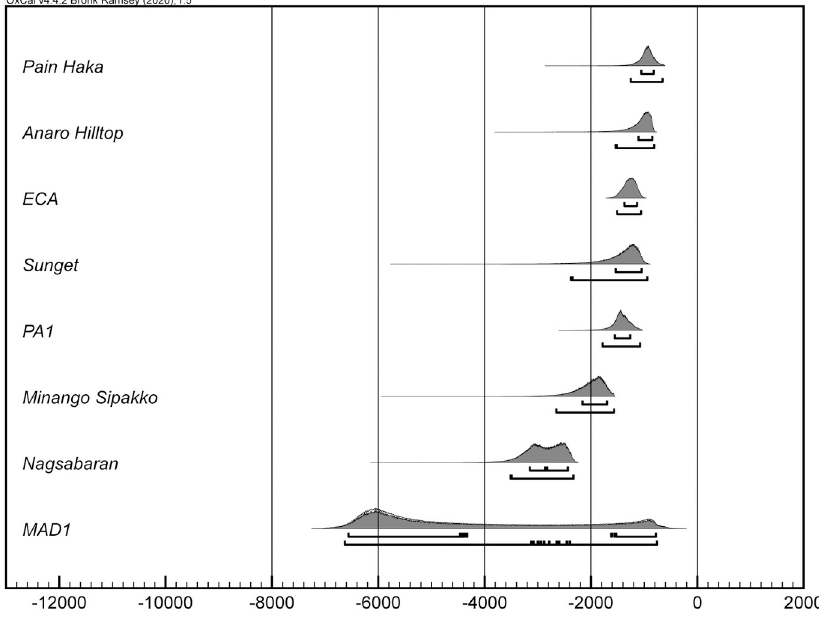
Fig 2. Order of initial pottery appearance at archaeological sites. Chronological ordering of the HPDs for the start of ceramic deposition at a site-scale. The first lines beneath each distribution delimit 68.2% HPD and the second lines delimit 95.4%